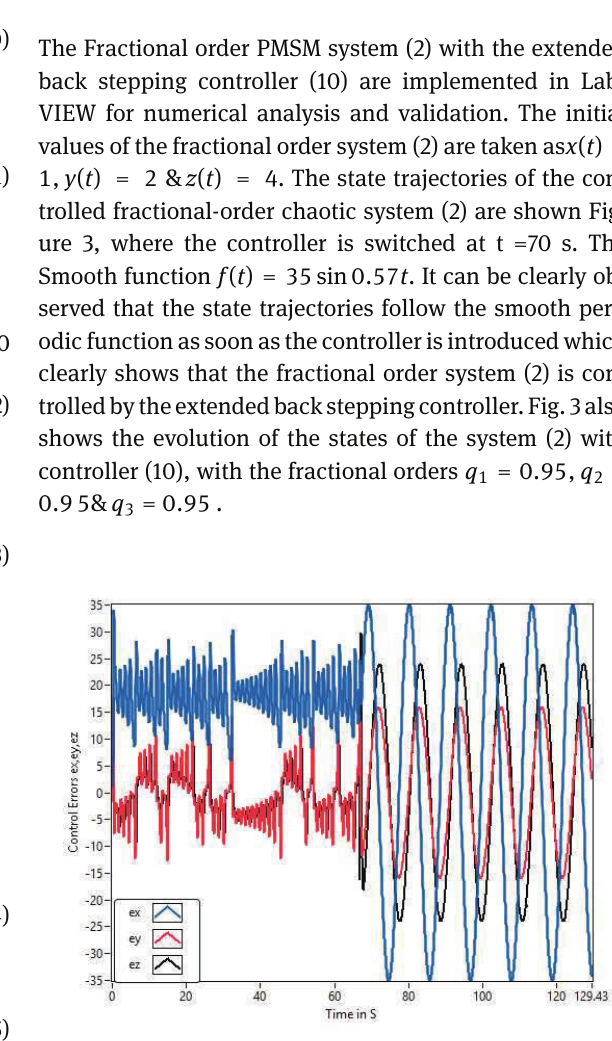
Fig. 3: State trajectories with control in action at t = 70